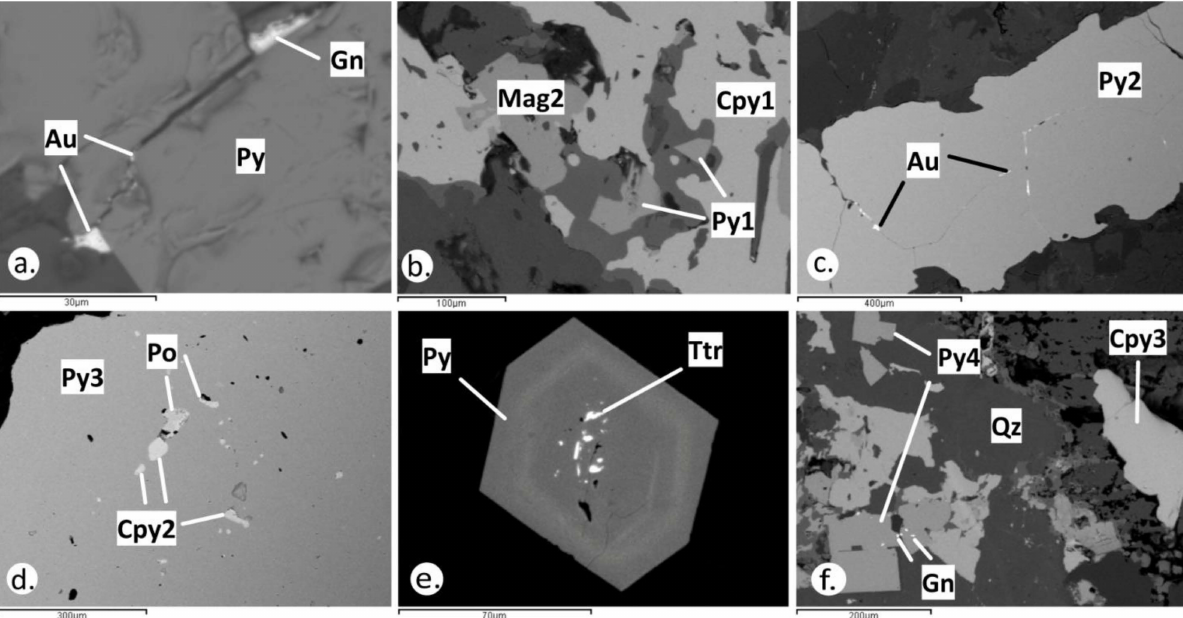
Figure 6. SEM back-scattered electron images of pyrite from different mineralization stages from the quartz monzonite ( a – d ) and the latite (e–i): ( a ) pyrite (Py), native gold (Au), and galena (Gn) in A-type vein from the potassic alteration; ( b ) euhedral pyrite (Py1), chalcopyrite (Cpy1), and magnetite (Mag1) from potassic alteration; ( c ) pyrite (Py2) in D-type vein and native gold (Au) in micro-cracks from sericitic alteration; ( d ) pyrite (Py3) bearing inclusions of chalcopyrite (Cpy2) and pyrrhotite (Po) from sericitic alteration; ( e ) euhedral pyrite (Py) bearing tetrahedrite (Ttr) inclusions in E-type vein related to epithermal overprint (assemblage 1); ( f ) euhedral pyrite (Py4) with galena (Gn) inclusions and chalcopyrite (Cpy3) in quartz (Qz) from E-type vein related to epithermal overprint (assemblage